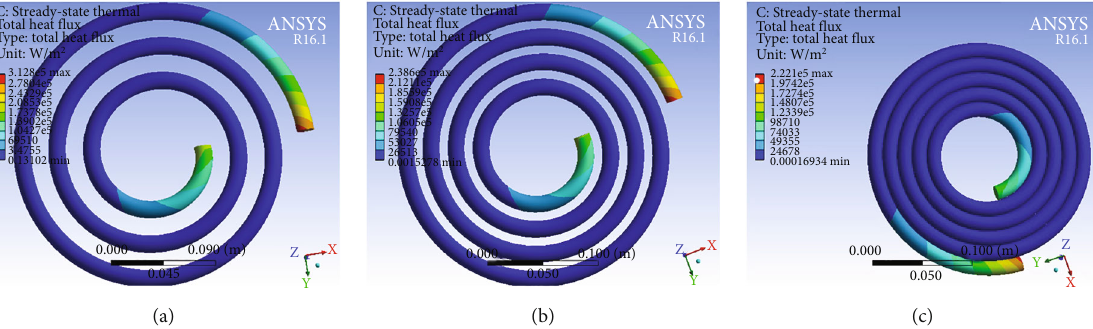
Figure 8: Heat fl ux distribution through (a) three convolutions, (b) four convolutions, and (c) fi ve convolutions of coil.